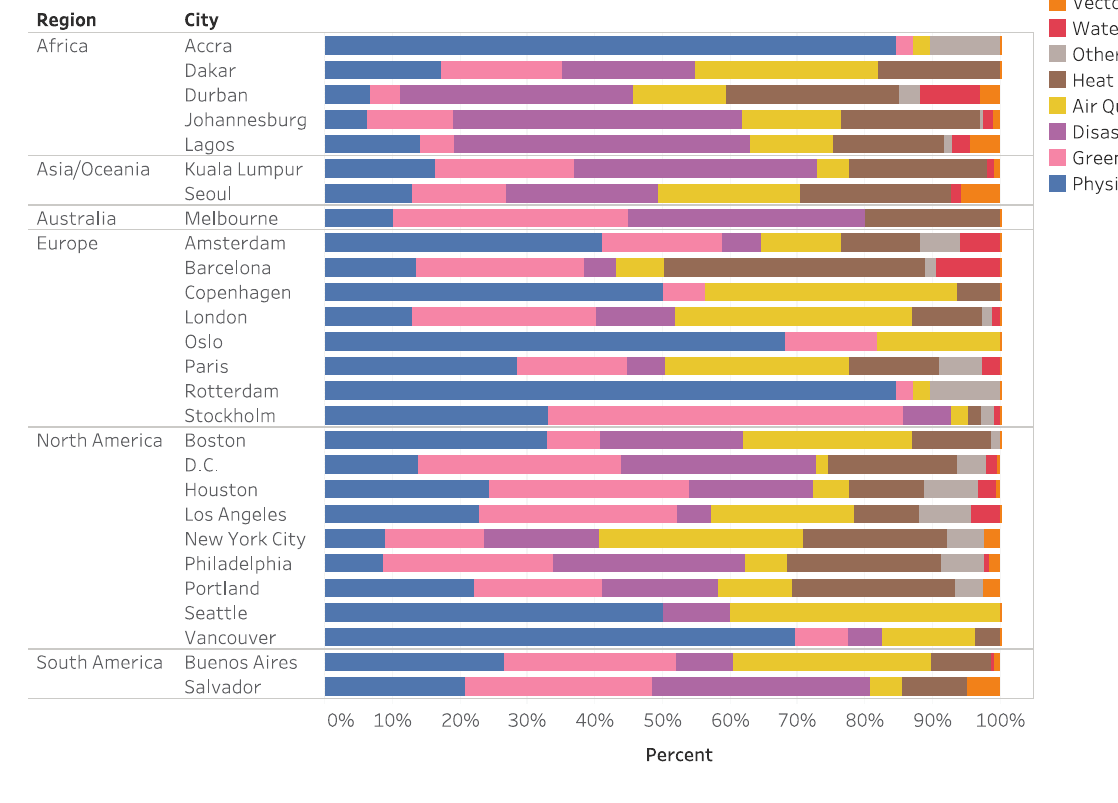
FIGURE 5 | Percent of exposure references by exposure sub-category for each of the 27 included